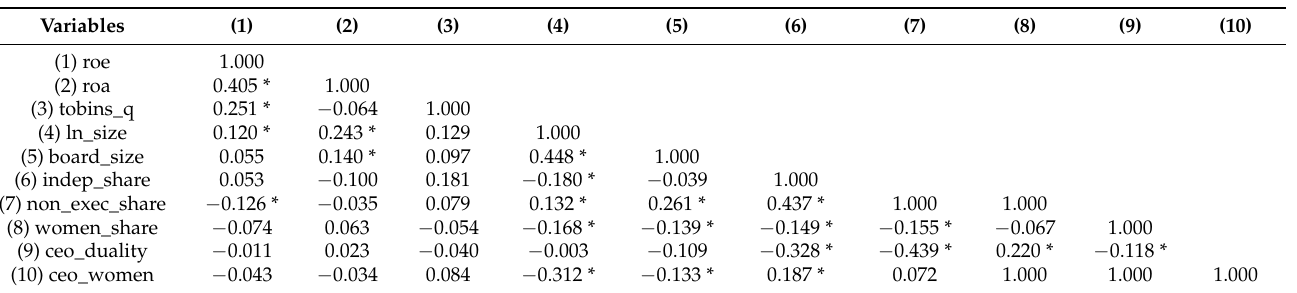
Table 3. Cross Correlations.